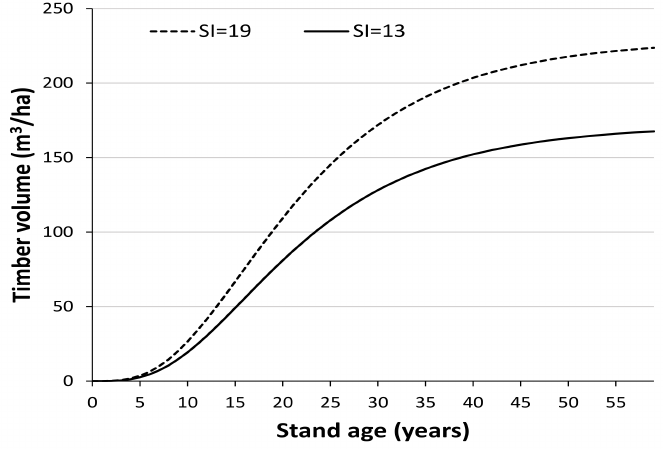
Figure 1. Projected yields for larch under two site productivity levels (low and high) in Gansu, Northwest China. Site index (SI) represents the top height (in meters) at a breast height age of